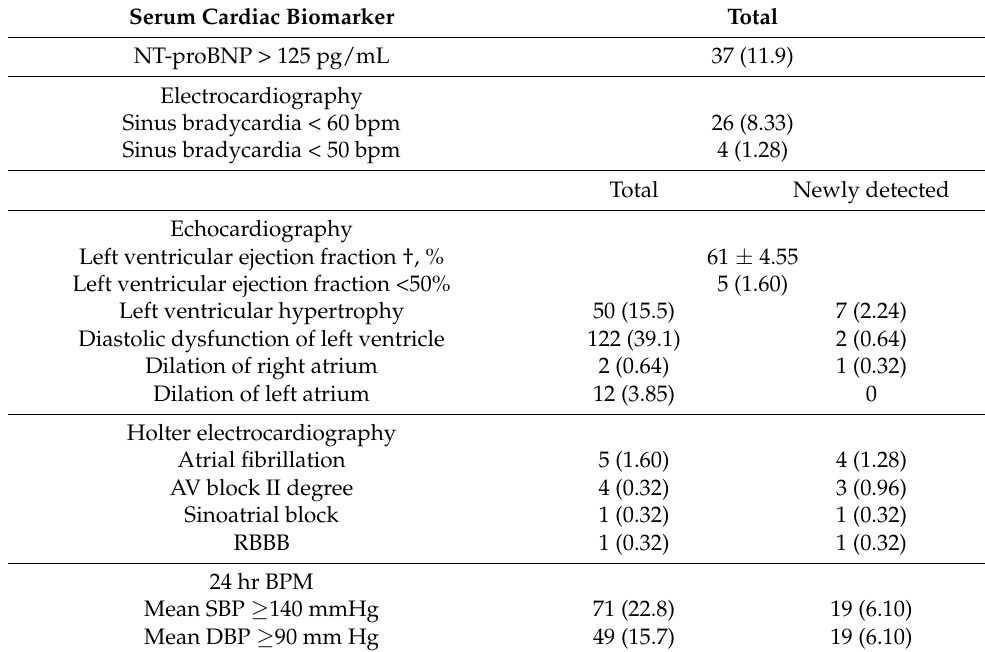
Table 3. Cardiac abnormalities detected in cardiac assessment of post-COVID-19